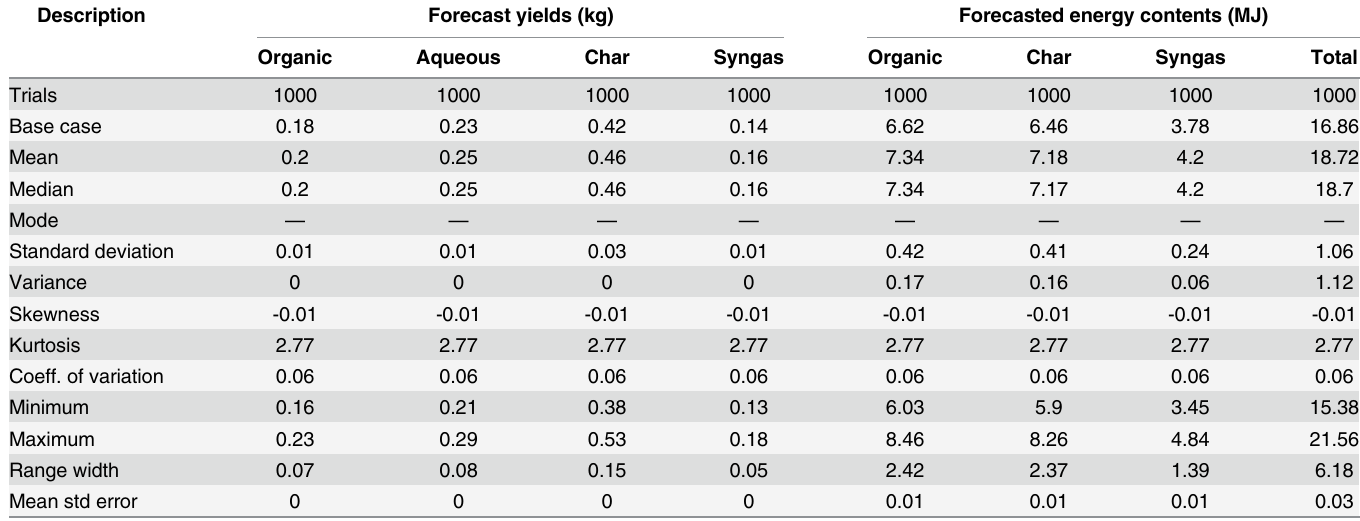
Table 2. Simulation results for 1.2 kg of co-biomass at